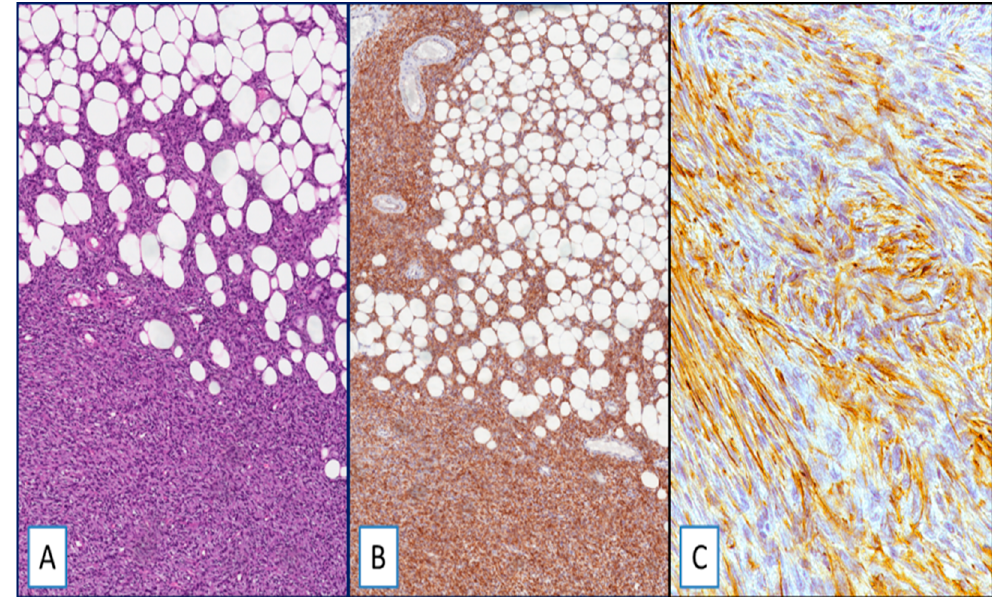
Figure 1. ( A ) Dermatofibrosarcoma protuberans (DFSP), classic-type: neoplastic cells infiltrate adipose tissue in a “honeycomb” pattern (hematoxylin and eosin (H&E); original magnification 100×); ( B , C ) strong and diffuse cytoplasmic staining for Wilms’ tumor 1 (WT1): (immunoperoxidase; original magnifications 100× ( B ) and 400× ( C )).